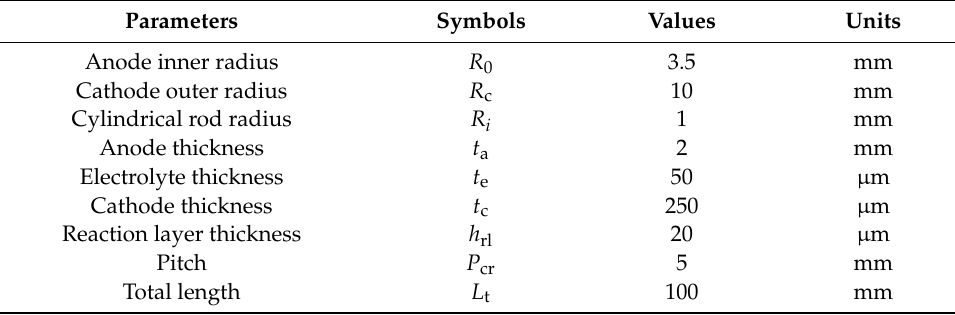
Table 1. The geometric parameters of the tubular solid oxide fuel cells investigated in this study. Parameters Symbols